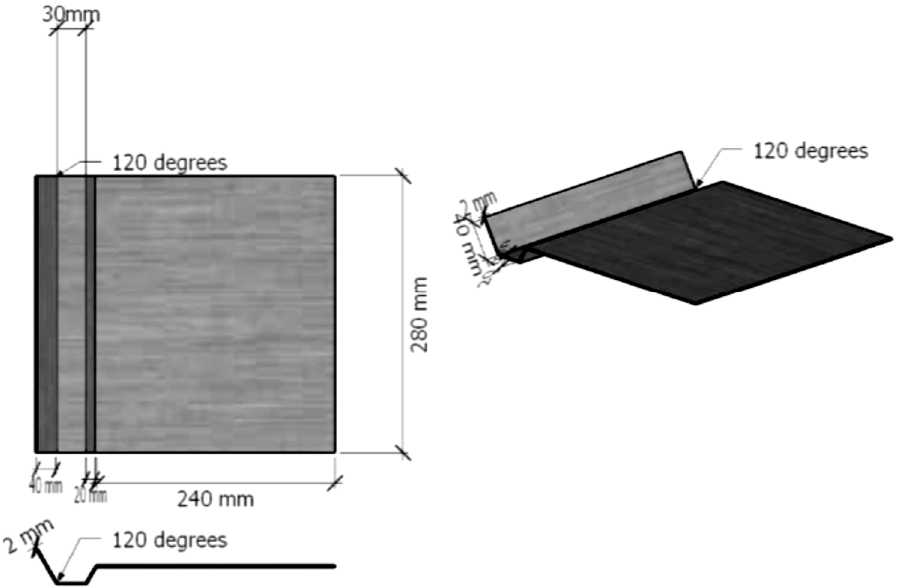
Figure 3. Schematic of an aluminum mold, with 2 mm thickness, for the 120° joint configuration.